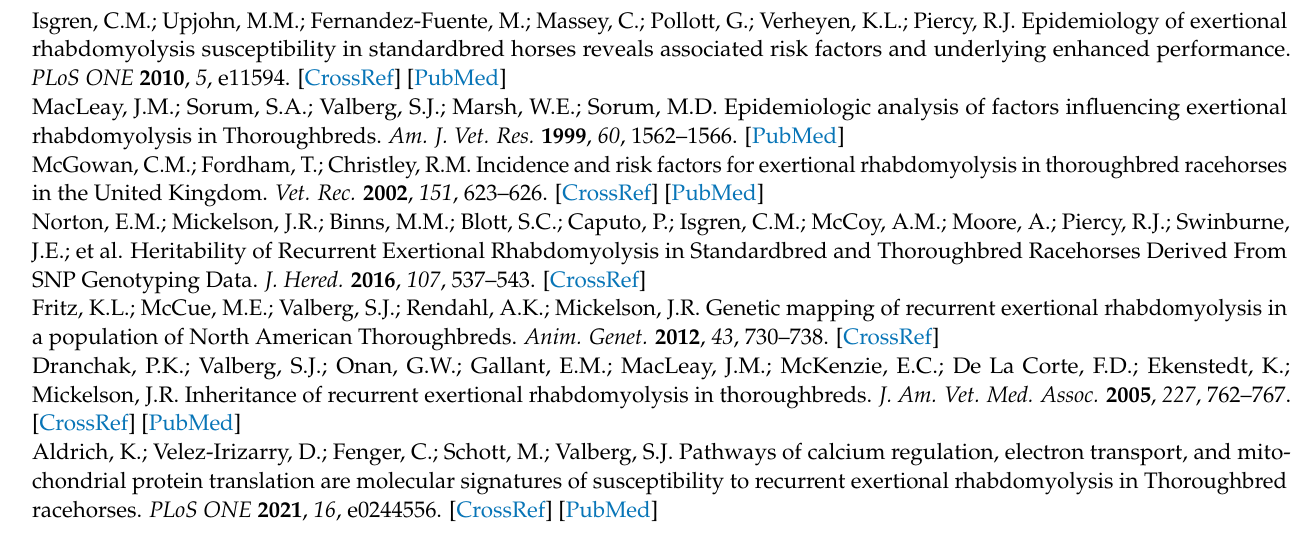
Figure S2: Principal component analysis of proteomic data from RER horses. Table S3: Differentially expressed genes in gluteal muscle of horses with recurrent exertional rhabdomyolysis and controls. Table S4: GO pathways enriched for down and up regulated differentially expressed genes. Table S5: Differentially expressed proteins in gluteal muscle of horses with recurrent exertional rhabdomyolysis and controls. Table S6: GO pathways enriched for down and up regulated differentially expressed proteins. Table S7: Reactome pathways for the merged differentially expressed gene and proteins in horses with recurrent exertional rhabdomyolysis and controls. Table S8: Co-inertia analysis of expressed genes and proteins in horses with recurrent exertional rhabdomyolysis and